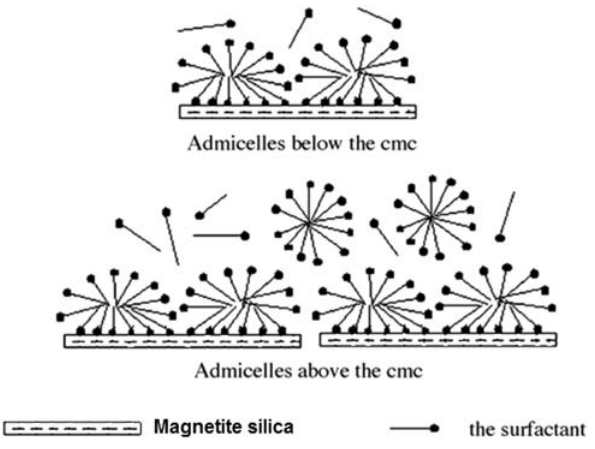
Figure 1: Typical structure of the surfactant aggregates formed on the surface of magnetite - silica [ 13 ]